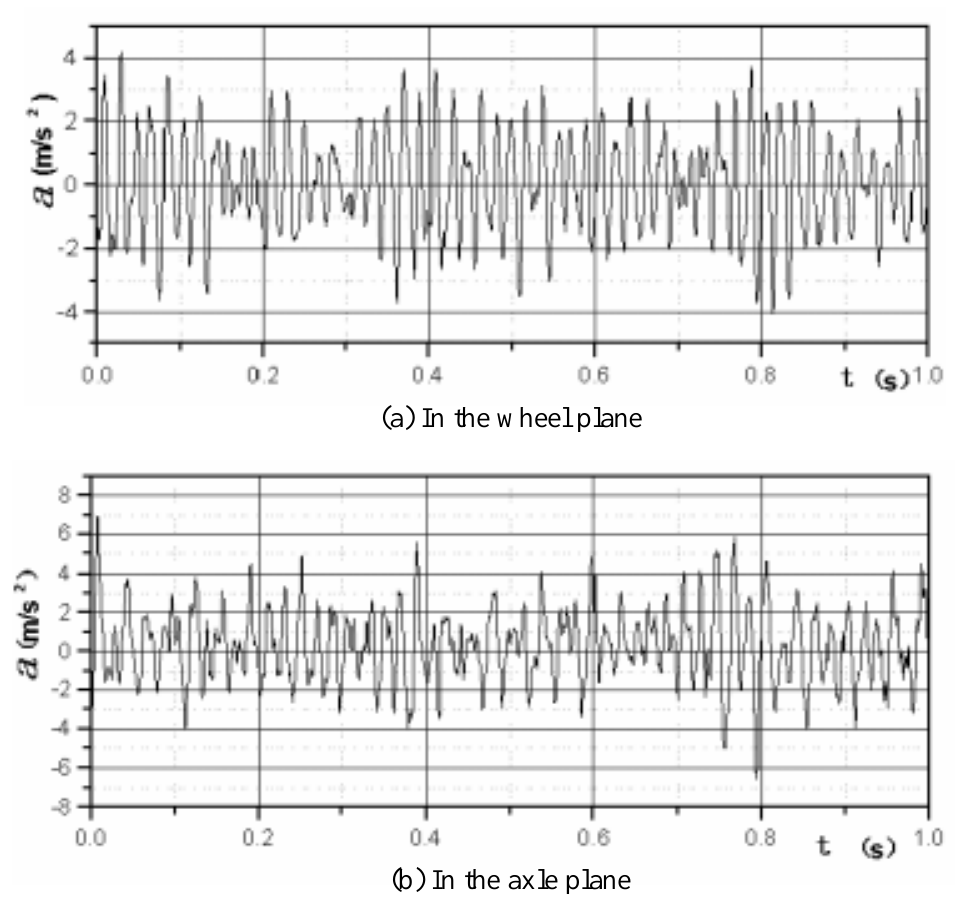
Fig. 7. (a) In the wheel plane (b) In the axle plane Real time responses of vertical accelerations for the tube of the rear absorber in the test rig. F = ( I l ε − ml l l ε 4 1 4 1 5 4 3 1